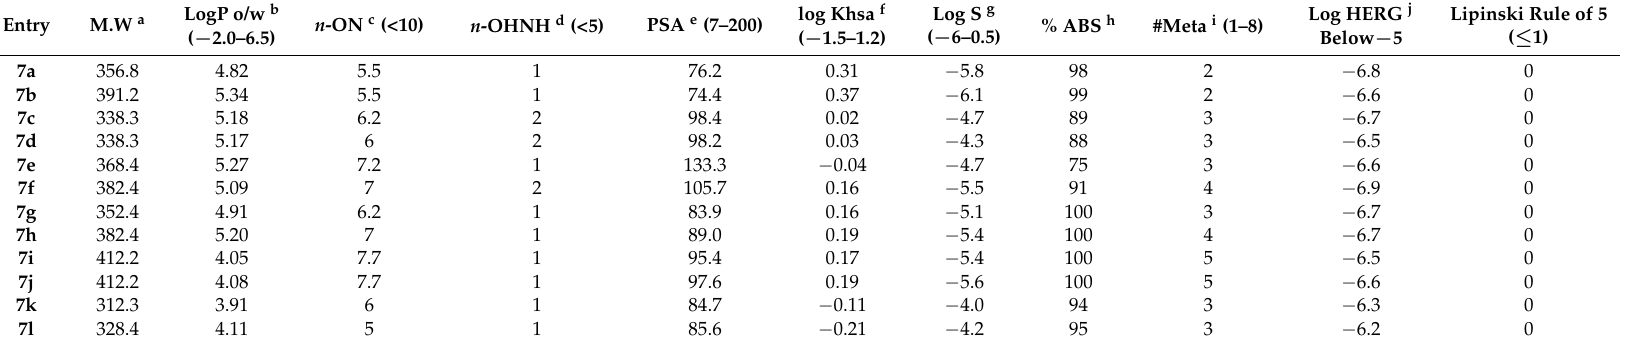
Table 4. In silico physicochemical pharmacokinetic parameters important for good oral bioavailability of the synthesized compounds 7 ( a – l